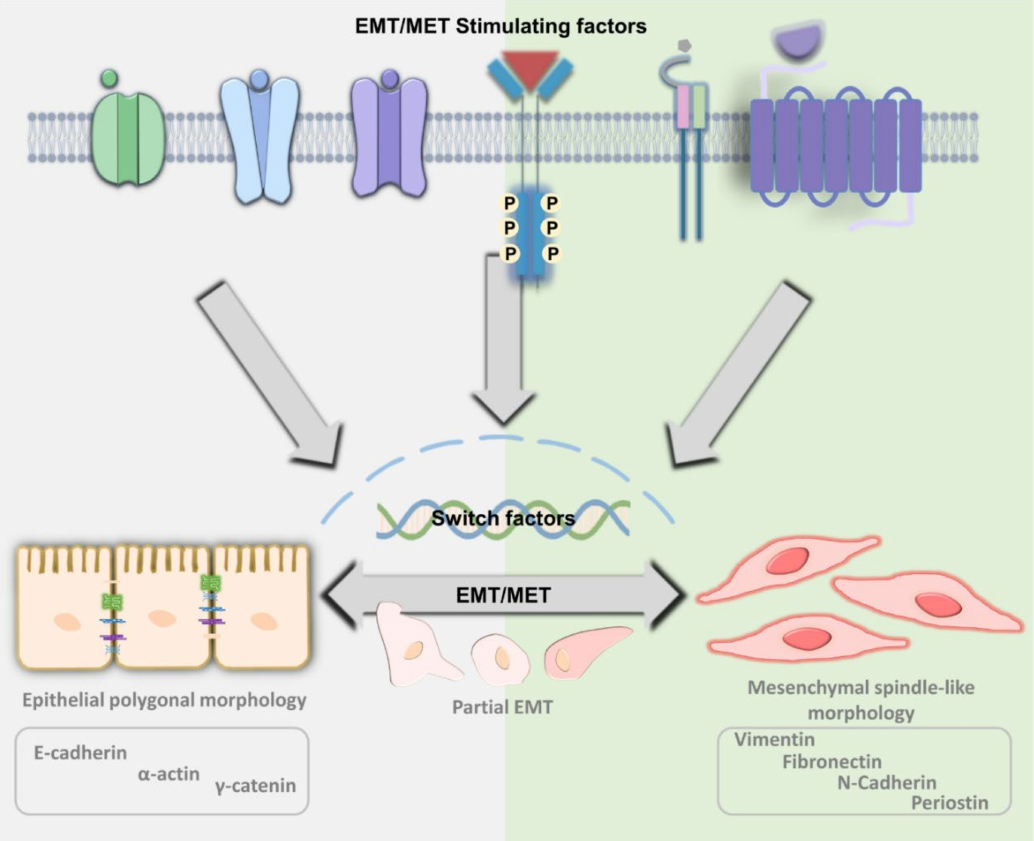
Figure 10. The molecular mechanism of EMT/MET. To date, multiple essential embryogenesis factors have been proven to contribute to EMT/MET by control diverse switch factor activity, in which the epithelial or mesenchymal status has been well characterized, but among them, the intermediated status, partial EMT empower cancer stemness, drug-resistant, and collective motility, such plasticity contribute to tumor heterogeneity of